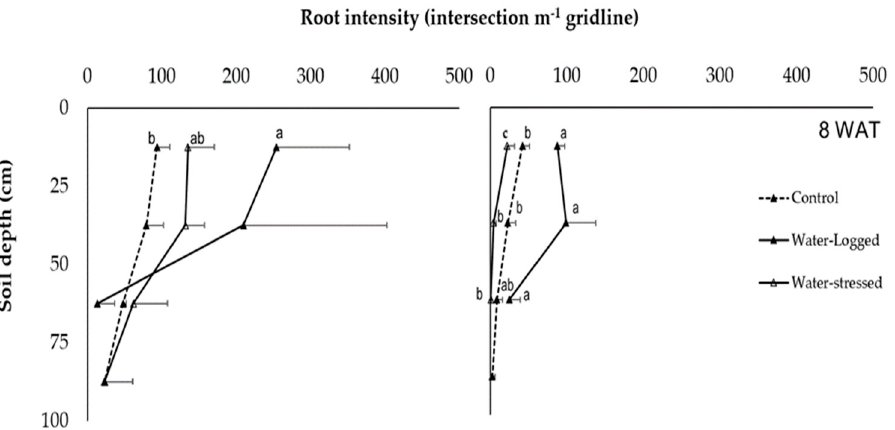
Figure 3. Root intensity (intersection m − 1 gridline) at 8 WAT under water-stress, water-logged, and control treatment at different soil depths for N. cadamba ( left ) and O. sumatrana ( right ). A two-way ANOVA test was used, followed by Tukey’s HSD ( p < 0.05, n = 3). Error bars indicate standard deviation. Different letters indicate that a significant difference was observed between the various conditions for each depth tested.